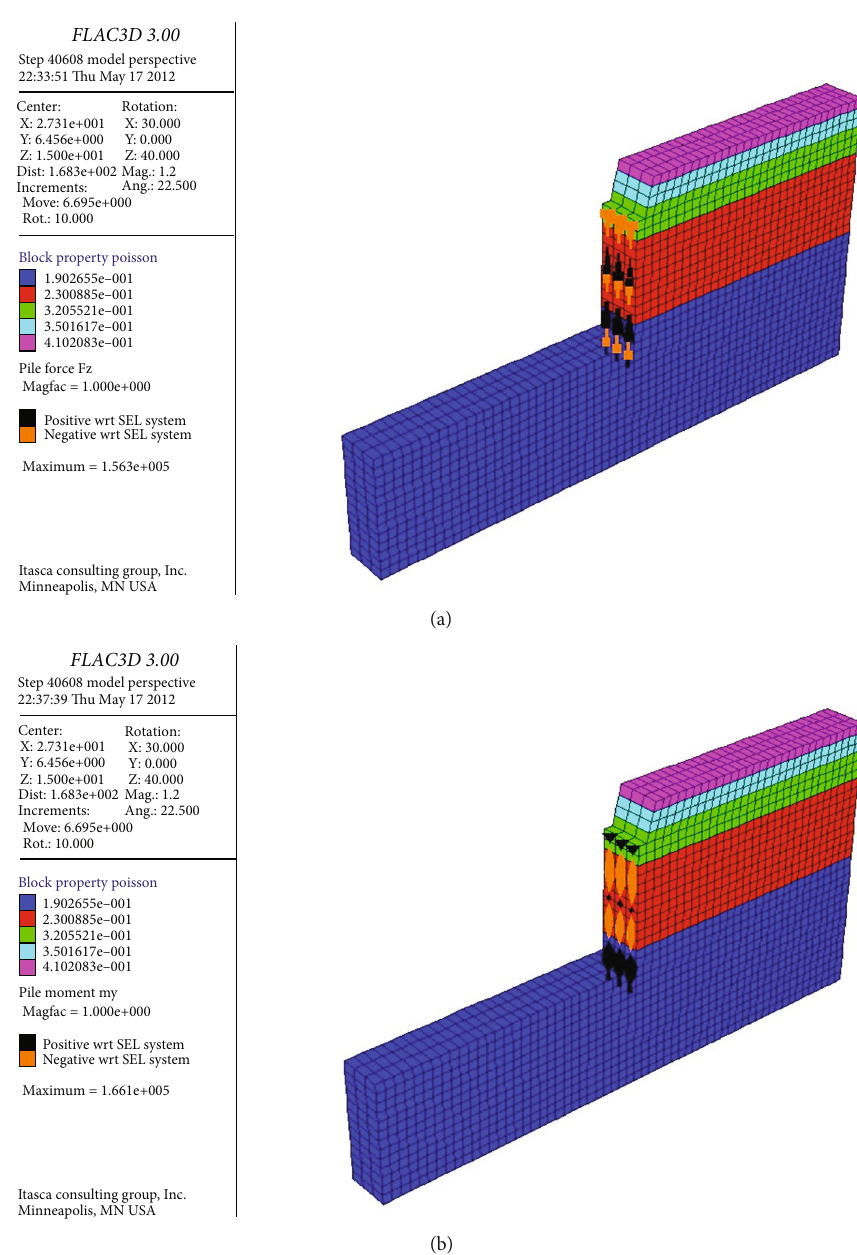
Figure 14: Numerical simulation results of shear force and a bending moment of supporting pile. (a) Simulation results of the shear force of the supporting pile. (b) Simulation results of the bending moment of the supporting